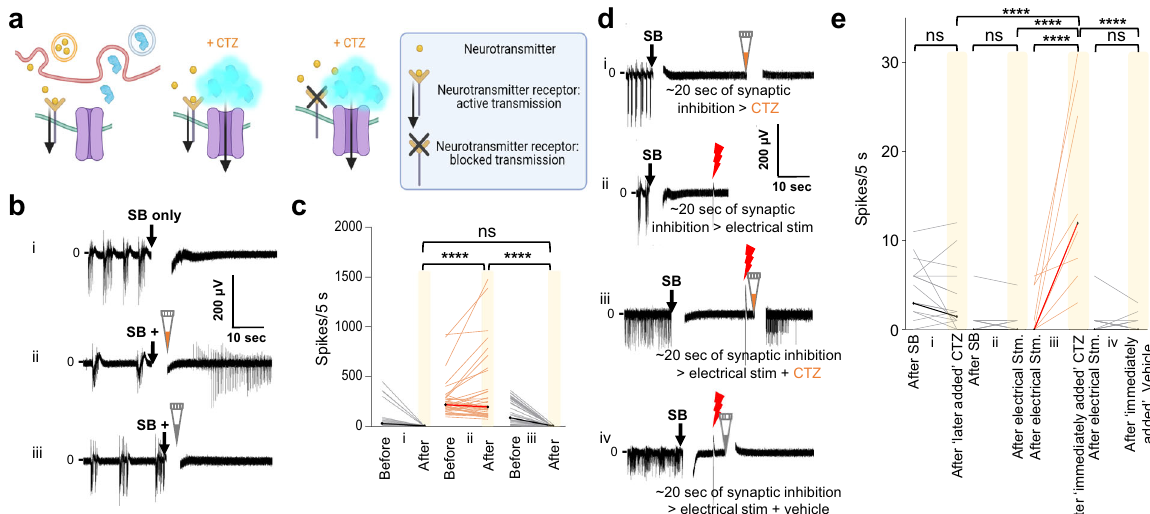
Fig. 4 Interluminescence elicits postsynaptic fi ring increase in the presence of synaptic blockers dependent on presynaptic neuronal activity. a Illustrations showing release of synaptic vesicle contents (neurotransmitters: yellow spheres, luciferases: blue enzymes) with spontaneous presynaptic activity inducing postsynaptic responses with transmitters alone (left panel), with transmitters and bioluminescent activation of opsins in the presence of CTZ (middle panel), and the effect of application of synaptic blockers (SB), allowing to isolate the effects of bioluminescence-mediated synaptic transmission (right panel). b Traces from representative electrodes of opsin (ChR2(C128S)) expressing population applying to the culture (i) synaptic blockers alone, (ii) synaptic blockers together with CTZ, or (iii) synaptic blockers together with vehicle. c Ladder plots of recordings under the conditions depicted in ( b ) from electrodes across opsin-expressing populations comparing number of spikes 5 s before and after (i) synaptic blockers alone, (ii) synaptic blockers together with CTZ, or (iii) synaptic blockers together with vehicle. (i) SB alone, n = 27, (ii) SB + CTZ, n = 37, (iii) SB + vehicle, n = 38; SB alone (after) v/s SB + CTZ (after), p < 0.0001; SB + CTZ (after) v/s SB + vehicle (after), p < 0.0001; SB alone (after) v/s SB + vehicle (after), p = 0.7305; Mann – Whitney test. d Traces from representative electrode recordings of opsin-expressing population applying to the culture synaptic blockers followed after ~20 s by application of (i) CTZ, (ii) electrical stimulation, and electrical stimulation together with either (iii) CTZ or (iv) vehicle. e Ladder plots of recordings under the conditions depicted in ( d ) across populations. (i), n = 18, SB (after) v/s CTZ added ~20 s later (after), p = 0.4022; (ii), n = 35, SB (after) v/s electrical stimulation (after) p > 0.9999; (iii), n = 10; electrical stimulation (after) v/s immediate CTZ treatment (after), p < 0.0001; (iv), n = 35, electrical stimulation (after) v/s immediate vehicle treatment (after), p = 0.8553; Mann – Whitney test. Signi fi cant increase in activity of opsin-expressing populations is observed only when CTZ is applied immediately following electrical stimulation and not when CTZ or electrical stimulation are applied by themselves nor when vehicle is applied immediately following electrical stimulation (yellow bars: immediate CTZ (after) ( n = 10) v/s CTZ added ~20 s later (after), ( n = 18); electrical stimulation (after), ( n = 35); immediate vehicle (after), ( n = 35); p < 0.0001; Mann – Whitney test). The artifacts due to addition of reagents in MEAs are overlaid by a vertical white bar in the recording traces (the white gap right after addition of SB, CTZ or vehicle). Artifacts due to electrical stimulation are visible under the red bolts. ns, not signi fi cant; **** p < 0.0001.